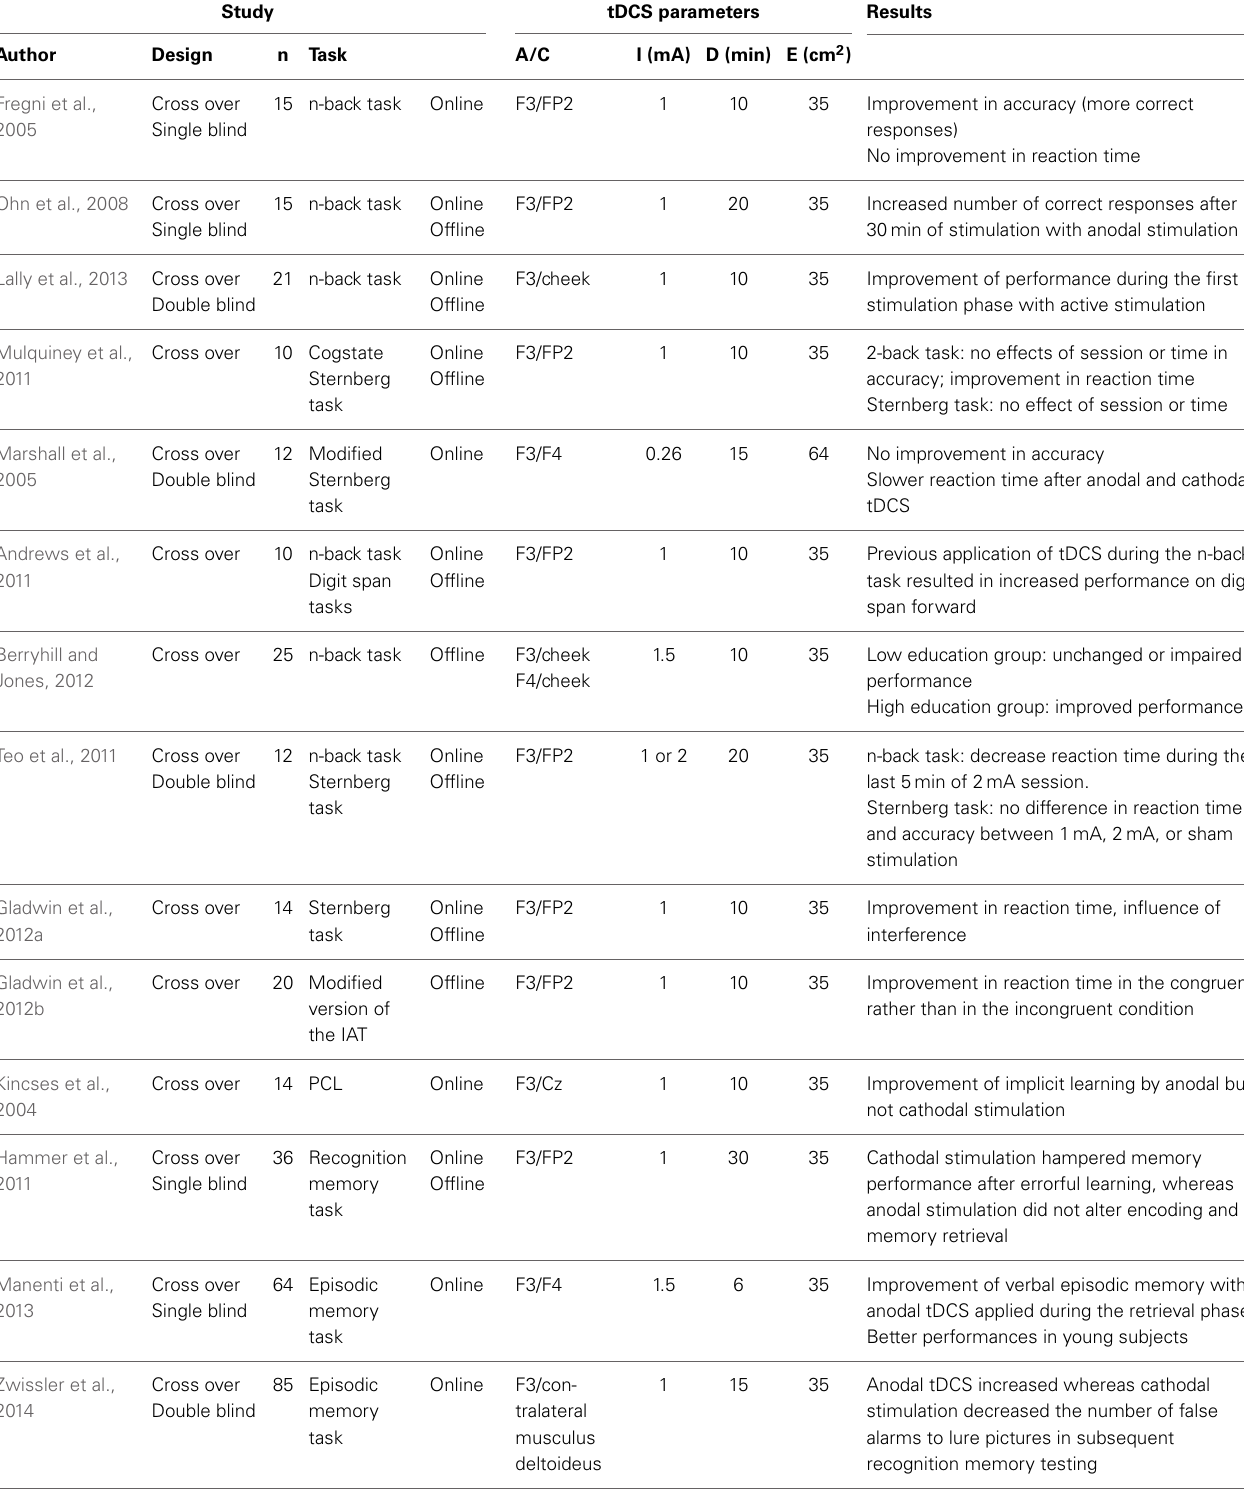
Table 1A | Studies investigating the cognitive effects of tDCS in healthy